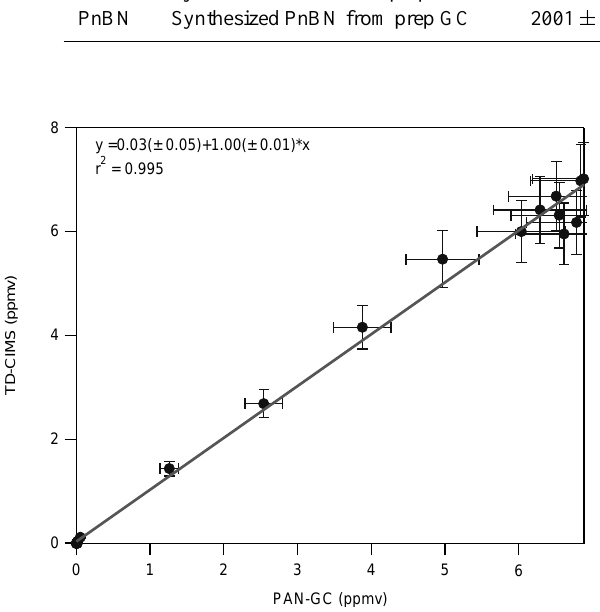
Fig. 7. Photolytically generated PAN inside the environmental chamber as measured by the TD-CIMS and the NCAR fast